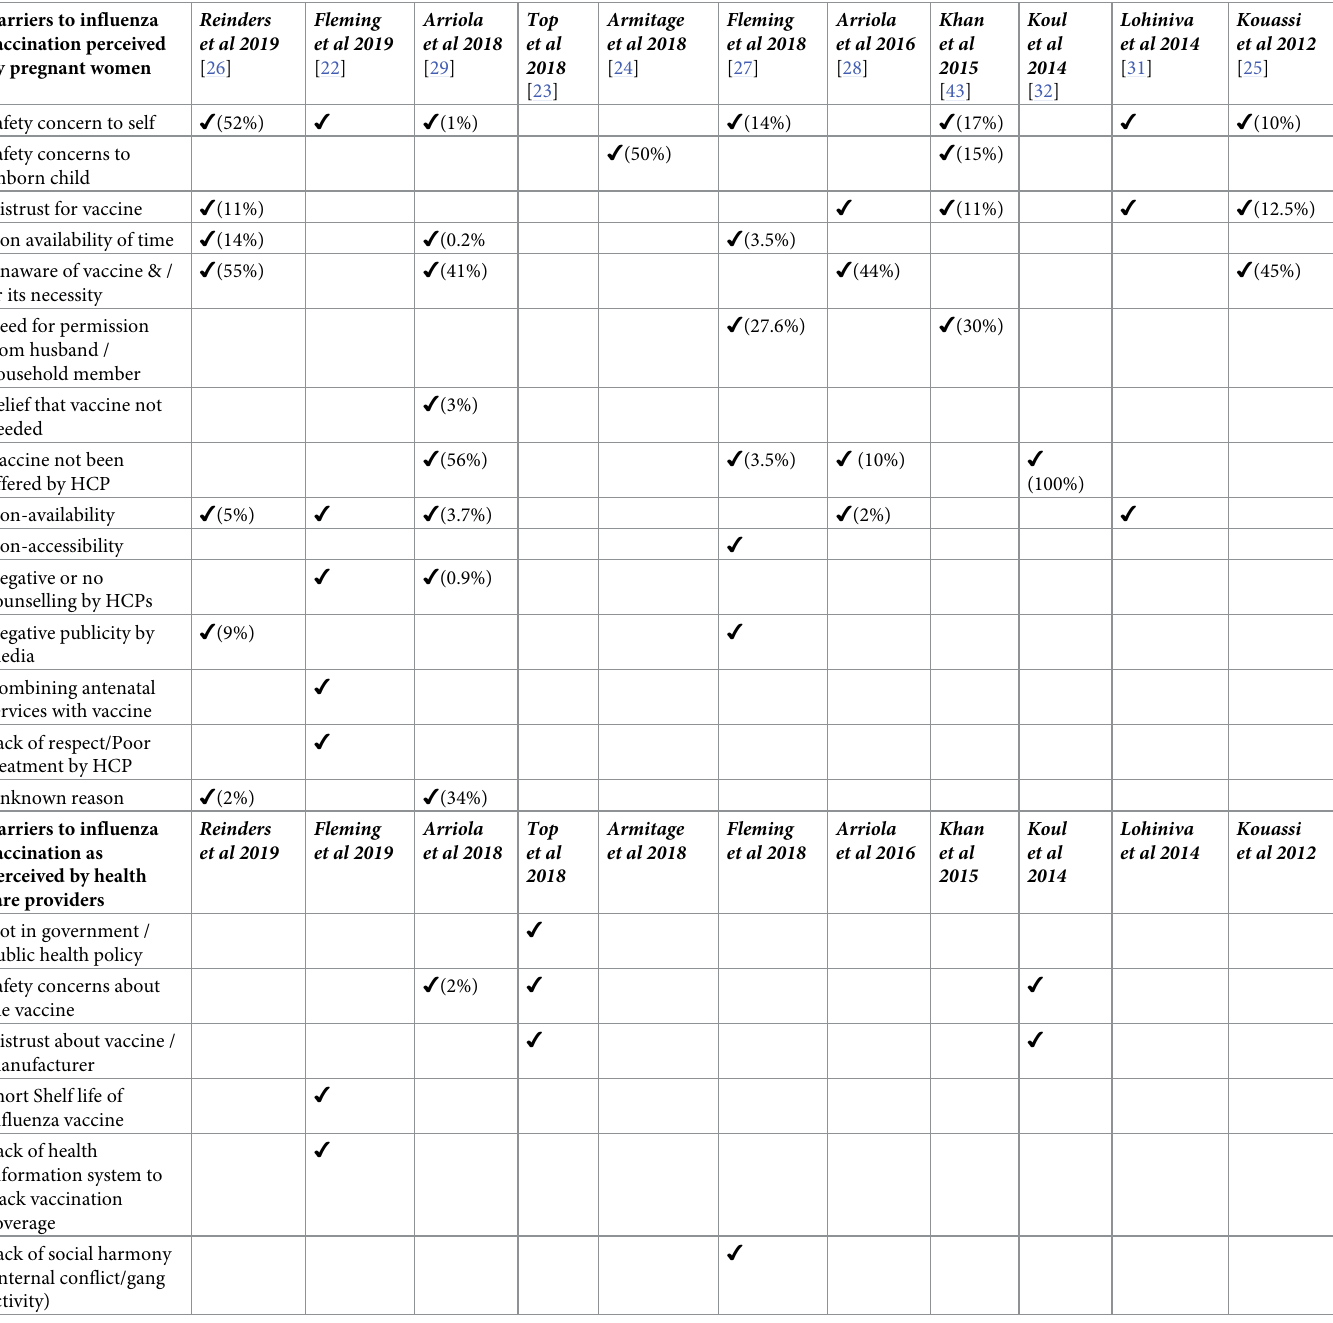
Table 4. Barriers to maternal influenza vaccination as perceived by pregnant women and health care providers � . Barriers to influenza vaccination